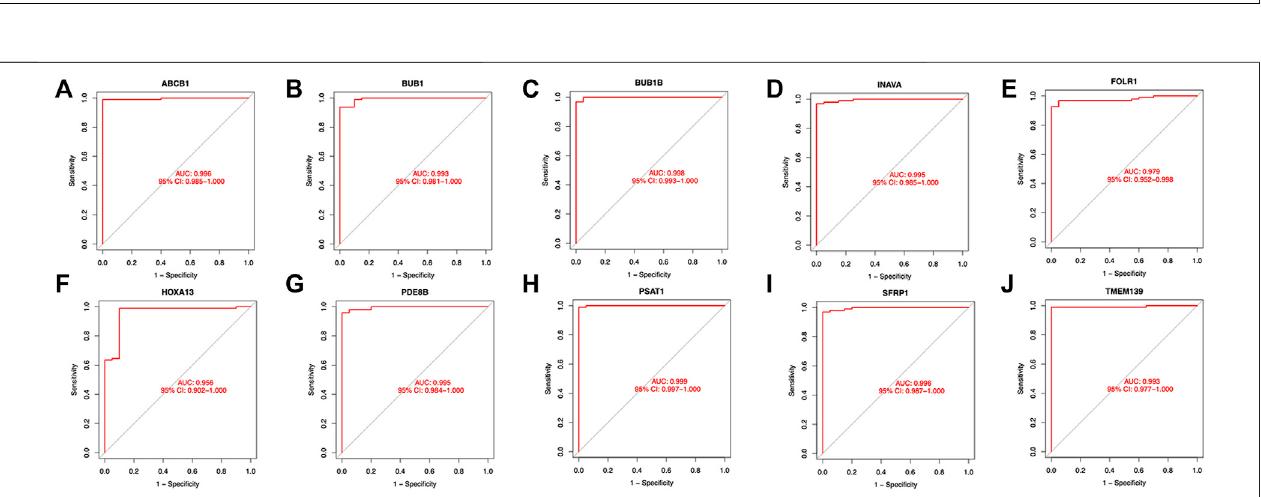
FIGURE6 | ROCcurvesof the OCgroup in the training set. (A-J) The fi gure shows the Roc curve often intersection genes in the training set A. The abscissa is the false positive rate, which is represented by 1-speci fi city, and the ordinate is the true positive rate, which is represented by sensitivity.